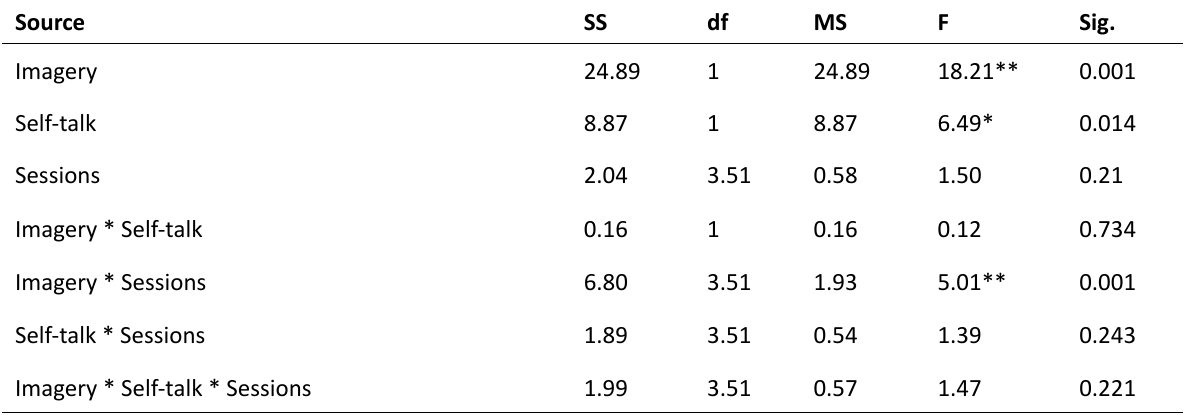
Table 1. Results of mixed ANOVA with repeated measures in acquisition phase